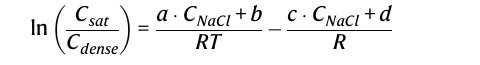
values are shown with S.D. as the error bars to show the variation between repli- cates.Eachdatasetforagiven